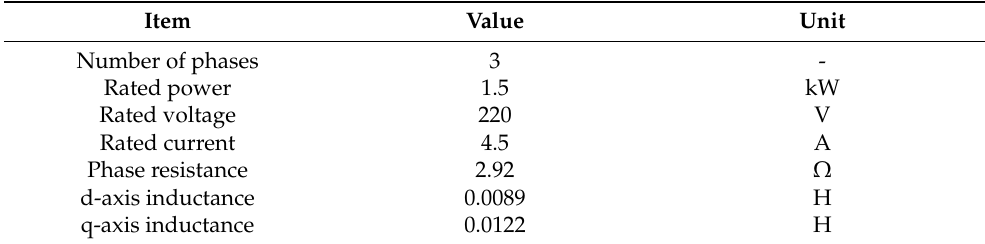
Table 1. The main characteristic parameters of the